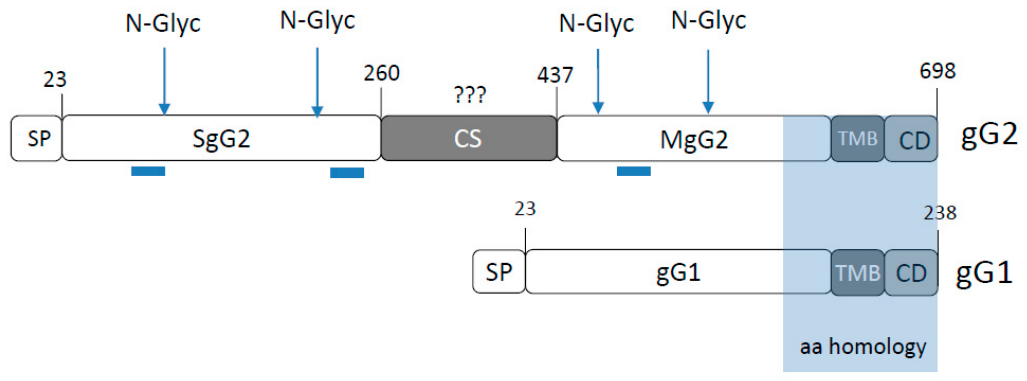
Figure 1. Schematic representation of gG from herpes simplex virus type 1 (HSV-1) and type 2 (HSV-2), containing the most important domains. Secreted SgG2 and membrane bound MgG2 domains are indicated for gG2, light blue shaded box indicates region with higher amino acid homology between gG1 and gG2. Dark blue lines under gG2 protein indicate positions of antigenic peptides detected by several antibodies used to map gG2 features in the literature. Blue arrows on top of gG2 indicate positions of N-linked glycosylation. Indicated amino acid positions are based on HSV-2 strain 333 gG2 and HSV-1 strain 17 sequences. Abbreviations: SP, signalling peptide; SgG2, secreted N-terminal domain; CS, gG2 cleavage site; MgG2, mature membrane bound C-terminal domain; TMB, trans-membrane-domain; CD, cytoplasmic domain.